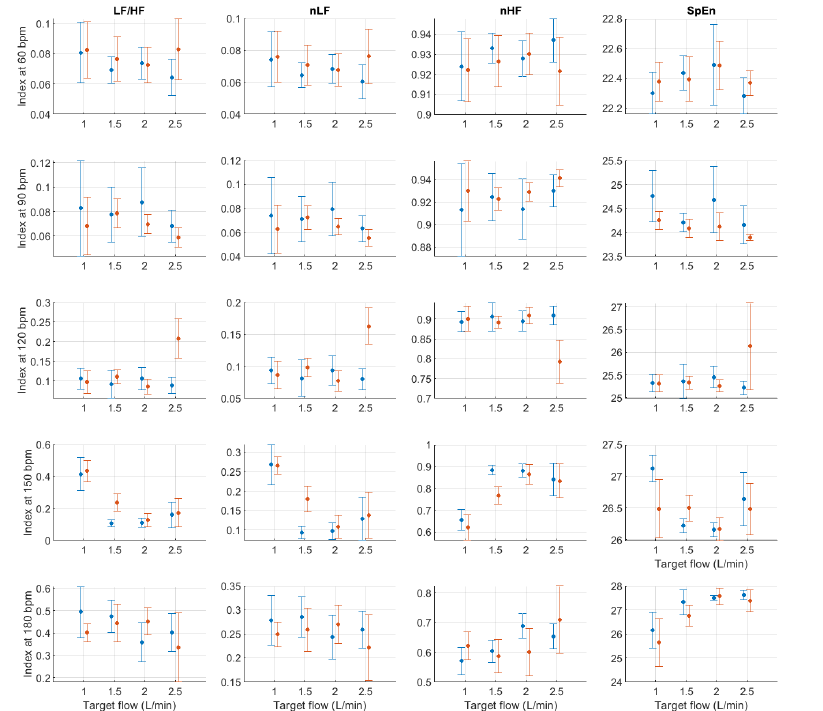
Figure A8. Mean and standard deviation of relative frequency-domain indices extracted from pulse rate variability under different stroke rates (SR) and target flows (TF, TF below 2.5 L/min) conditions, and measured from the radial (blue) and deep palmar arch (orange)